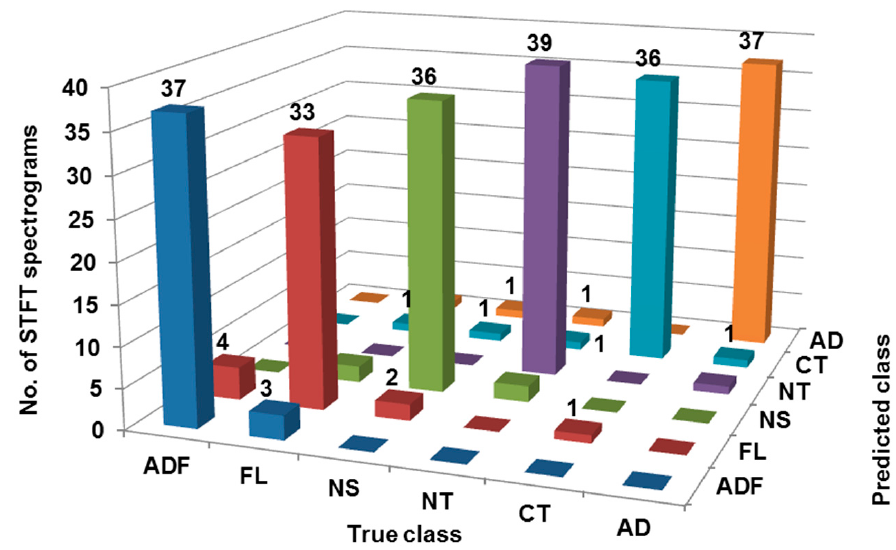
Figure 9. Confusion matrix considering blind dataset. For class ‘NS’, only 36 STFT spectrograms are correctly classified whereas 2 STFT spectrograms were misclassified as ‘FL’ and ‘NT’ each. Further, for class ‘NT’, only 39 STFT spectrograms are correctly classified whereas 1 STFT spectrogram was misclassified as ‘AD’. For class ‘CT’, only 36 STFT spectrograms are correctly classified whereas 1 STFT spectrogram was misclassified as ‘FL’, ‘NS’, and ‘AD’ each. Lastly, for class ‘AD’, only 37 STFT spectrograms are correctly classified whereas 1 STFT spectrogram was misclassified as ‘FL’, ‘NS’ and ‘NT’ each. Therefore, 218 out of 240 STFT spectrograms are correctly classified, hence the classification accuracy is 90.83% as shown in Table 8. Table 9 shows various performance indicators of classification considering the blind